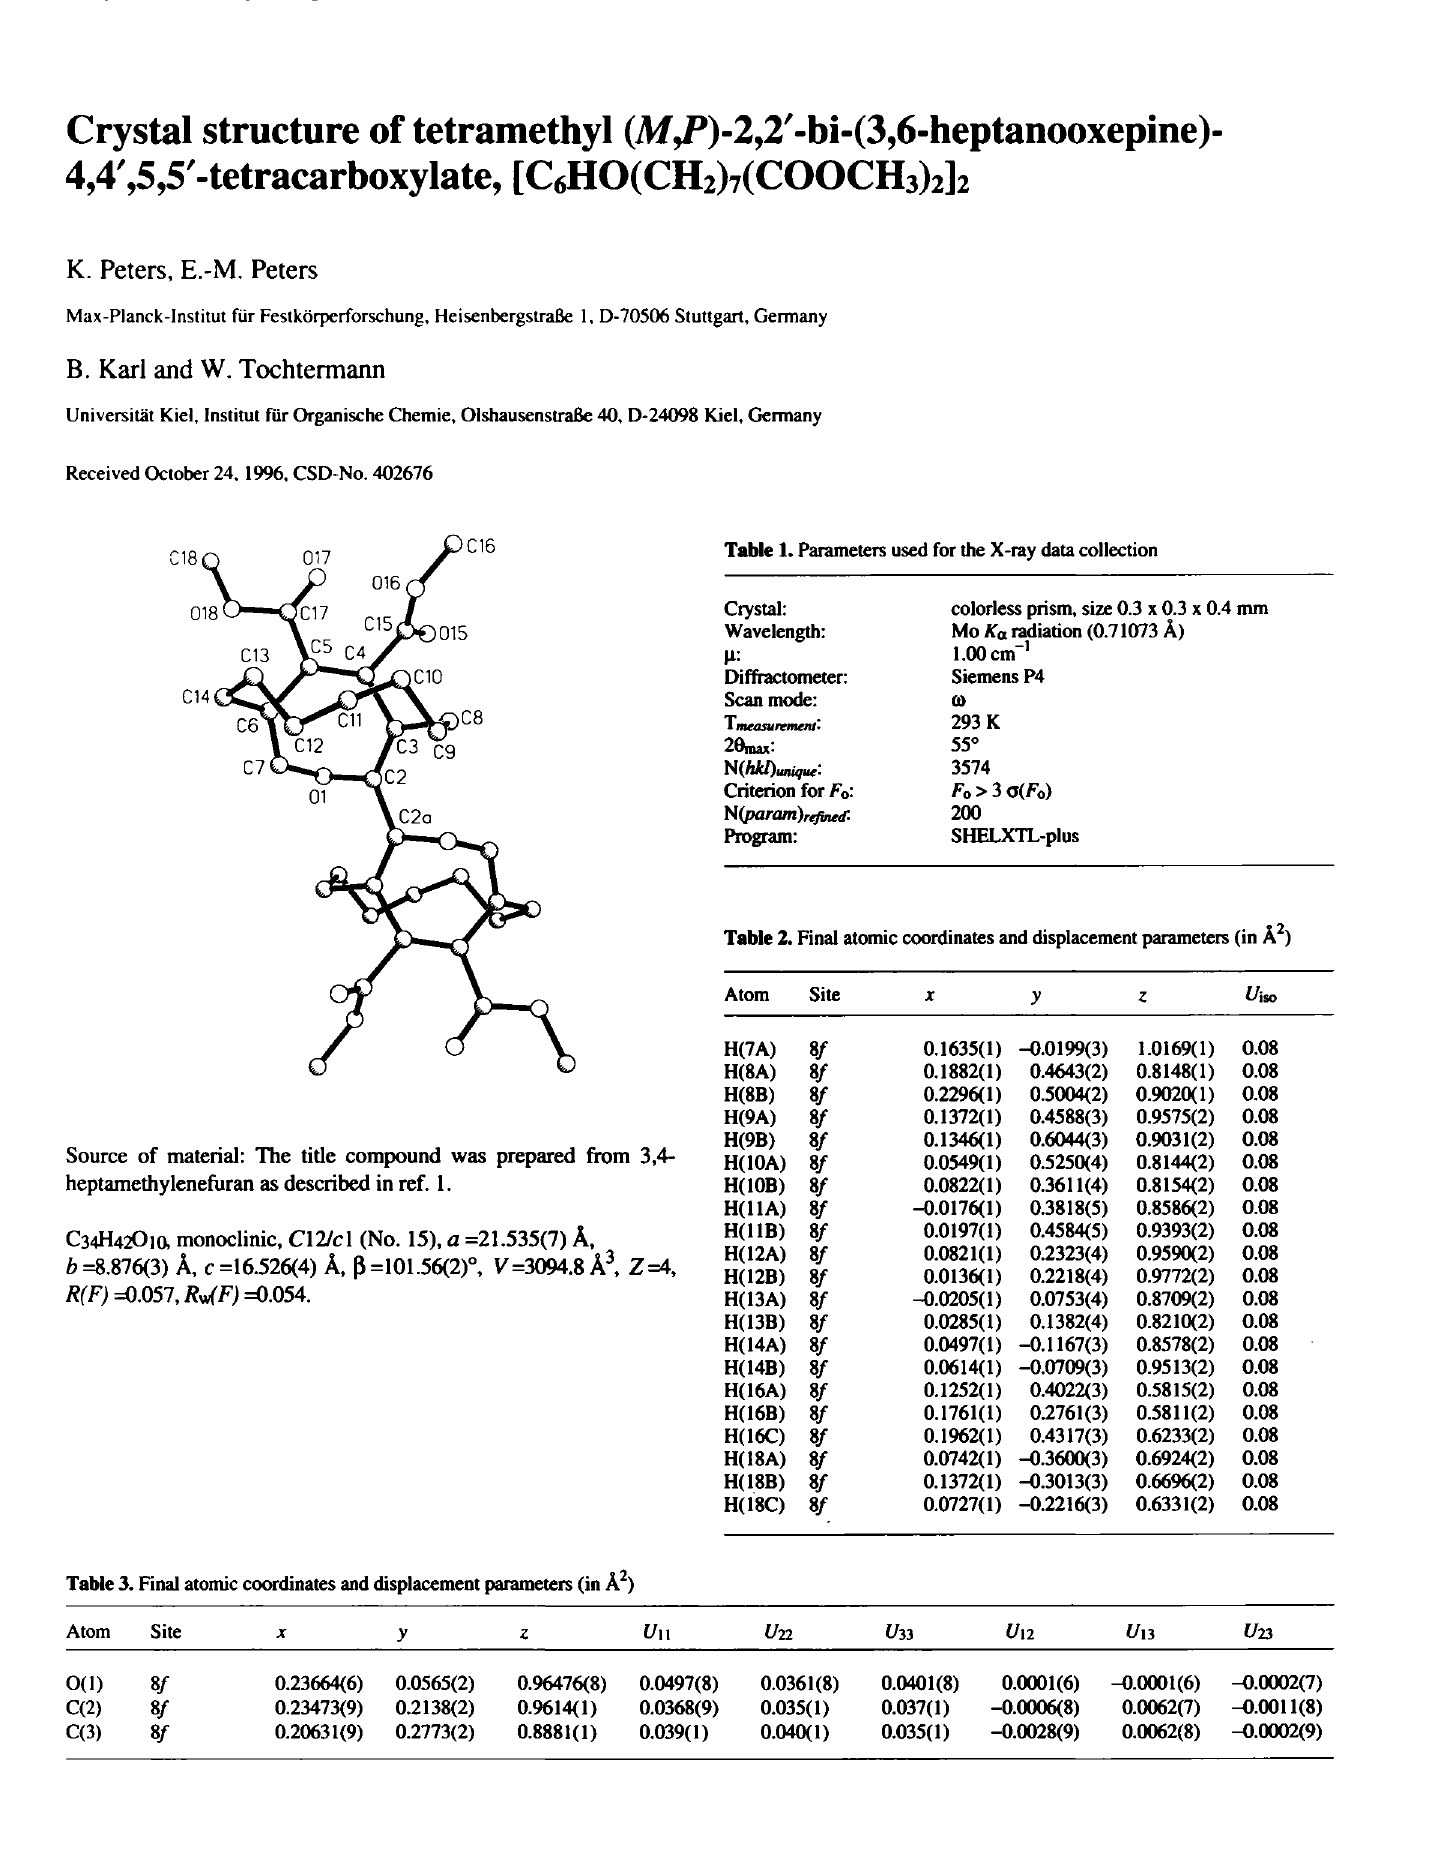
Table 1. Parameters used for the X-ray data collection